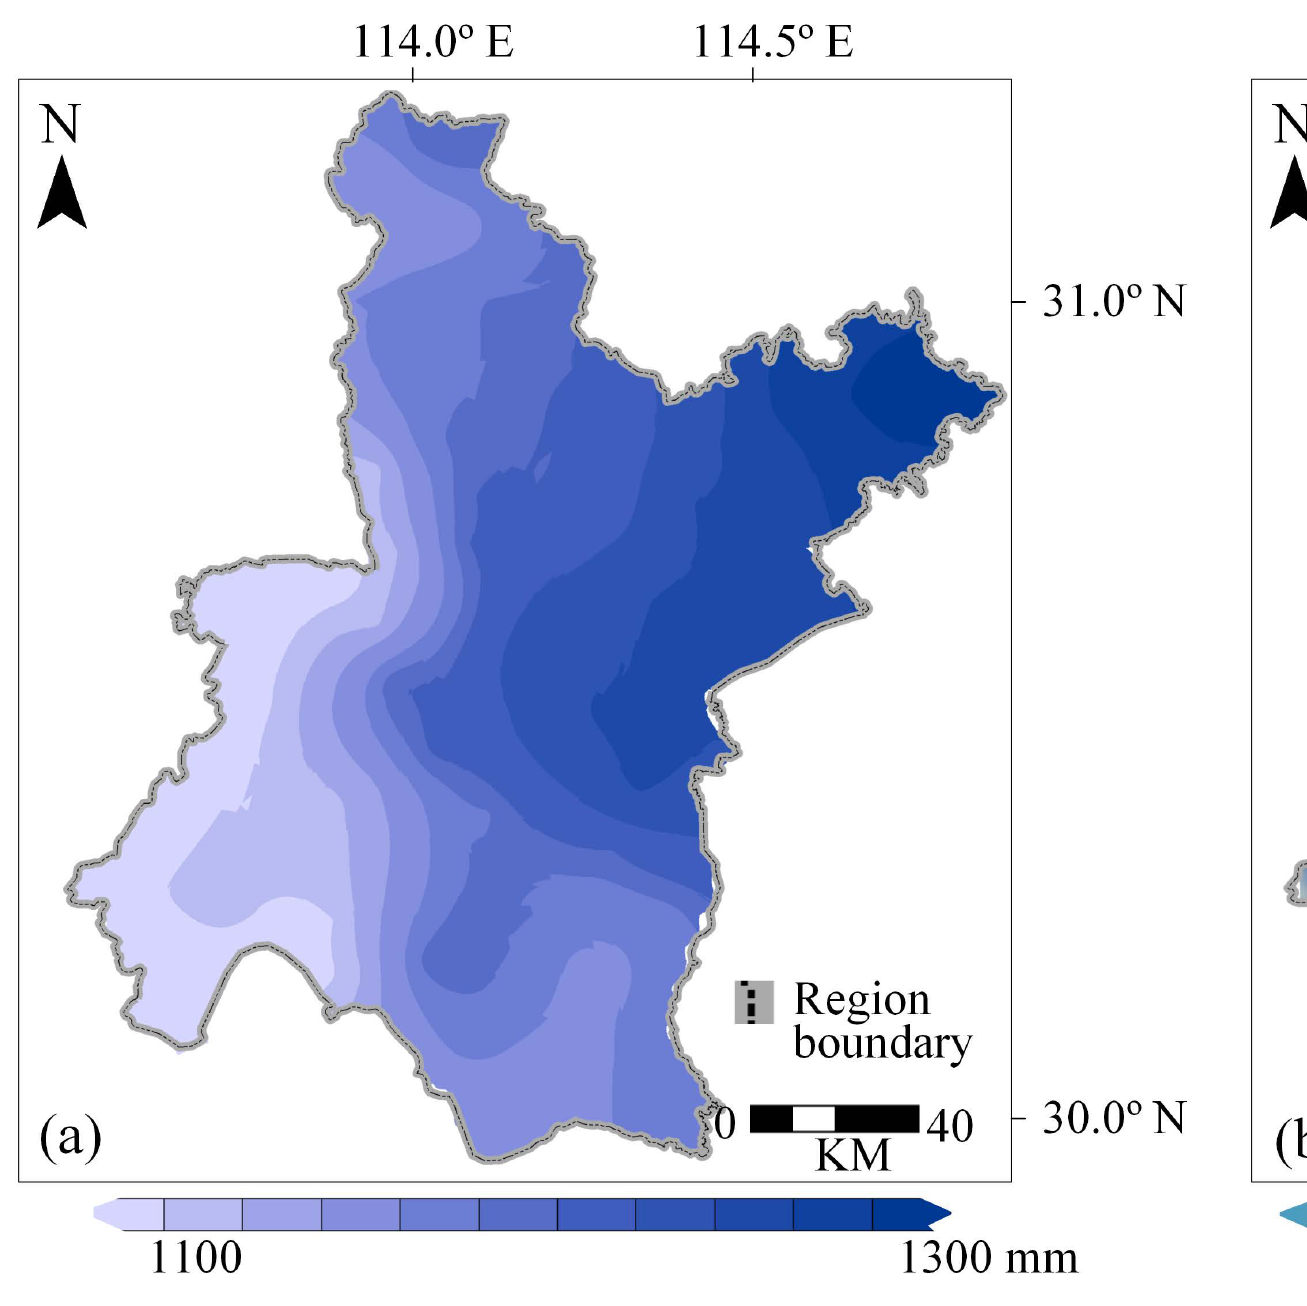
Figure 8. Annual precipitation ( a ) and its coe ffi cient for percentage of landscape (PLAND, ( b ) and aggregation index (AI, ( c )) from geographically weighted regression